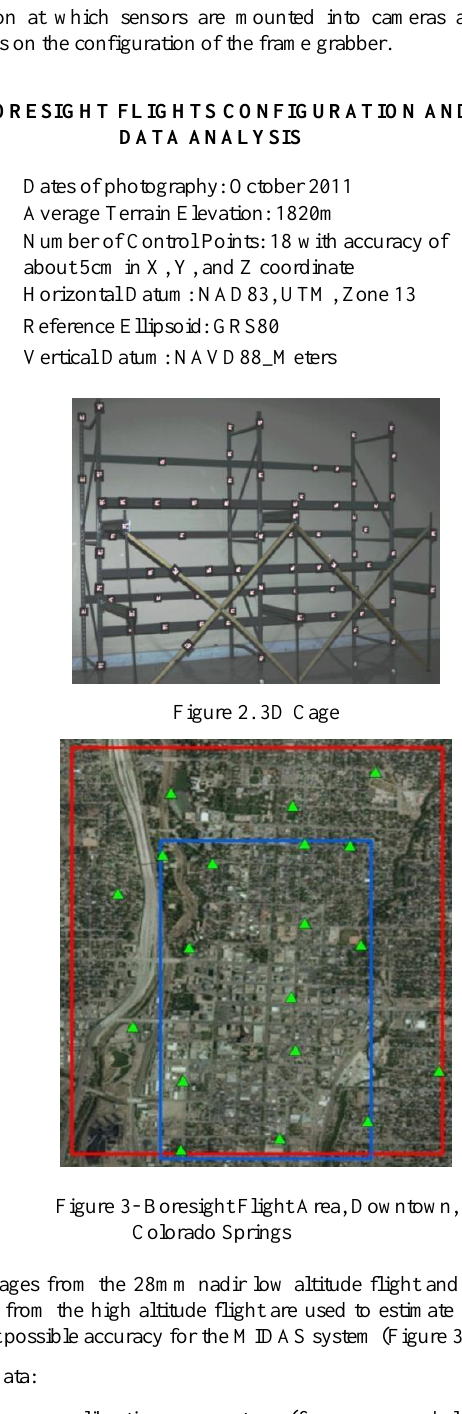
Image measurements with 4um standard